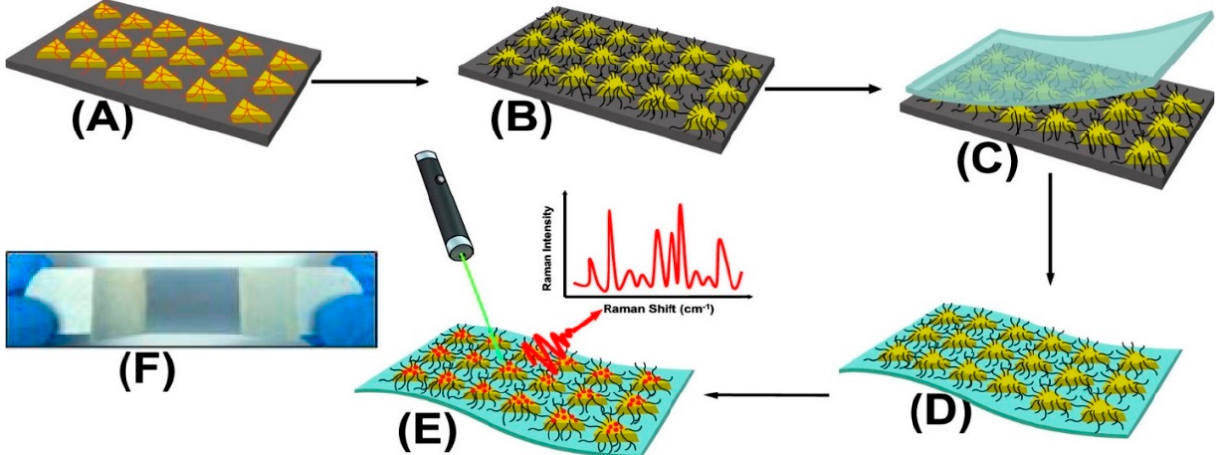
Figure 4. Schematic presentation of SERS substrate functionalization and drug detection process. ( A ) Chemically synthesized Au TNPs in acetonitrile are immobilized onto an APTES-functionalized glass substrate through incubation. ( B ) Au TNPs are functionalized with PEG-thiolate. ( C ) Adhesive tape is placed on the Au TNP-containing a glass substrate ( D ) Au TNPs are lift off from the glass to